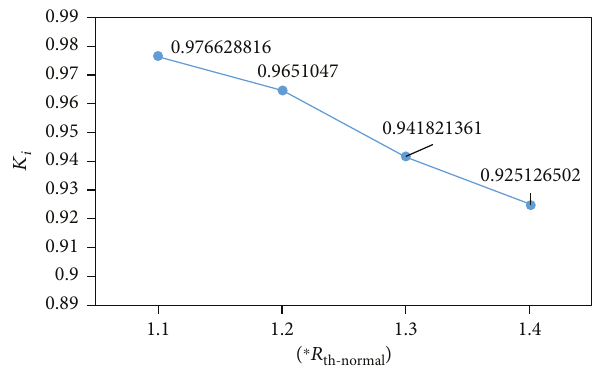
Figure 11: The coe ffi cient of current sharing between the D 1 and D 2 .